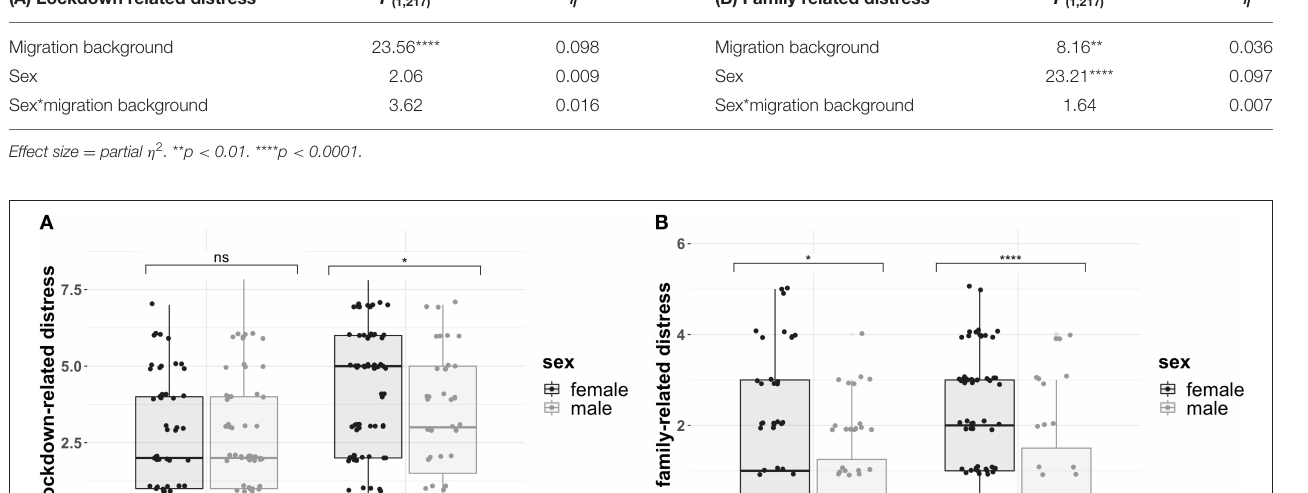
TABLE 3 | ANOVA table for (A) Lockdown related stress against migration background and sex. (B) Family related pressure against migration background and sex. (A) Lockdown related distress